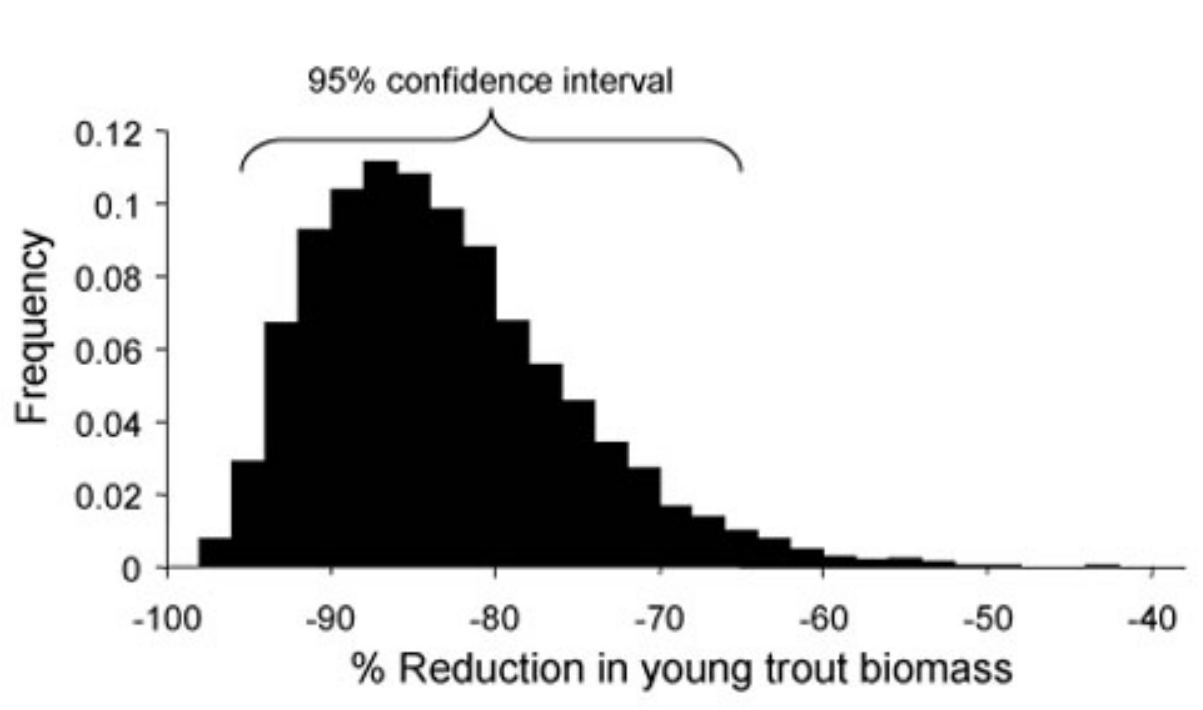
Fig. 10. Frequency distribution from the Monte Carlo analysis showing the predicted percent reduction in young trout biomass associated with the buffer width